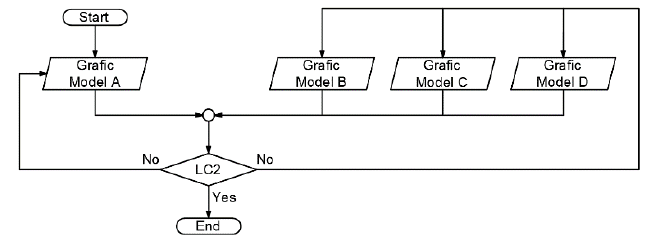
Figure 13. Level 2 Coordination workflow.